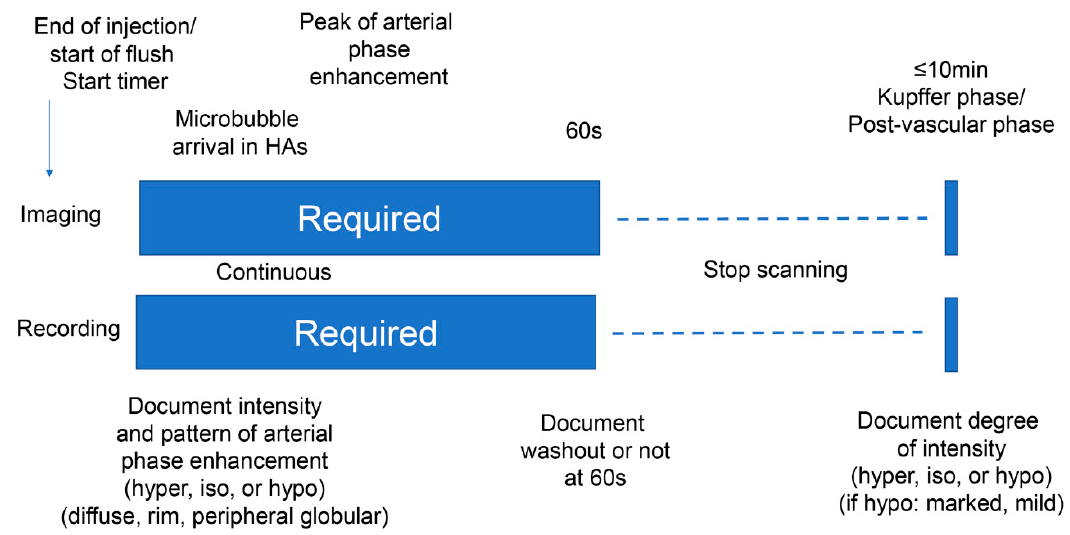
Figure 1. Sonazoid Contrast-Enhanced Ultrasound protocol.